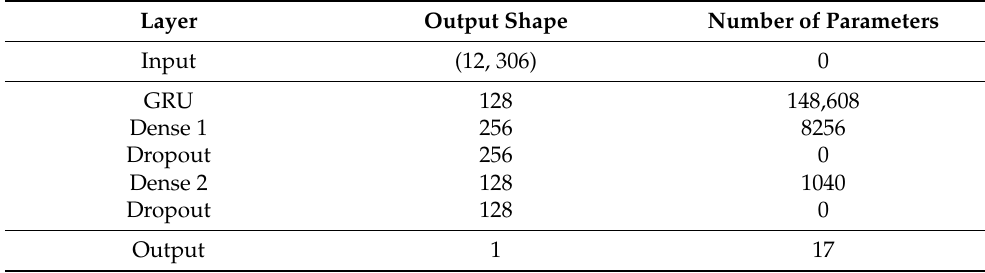
Table A2. Details of the GRU architecture considering both feet (12 channels).